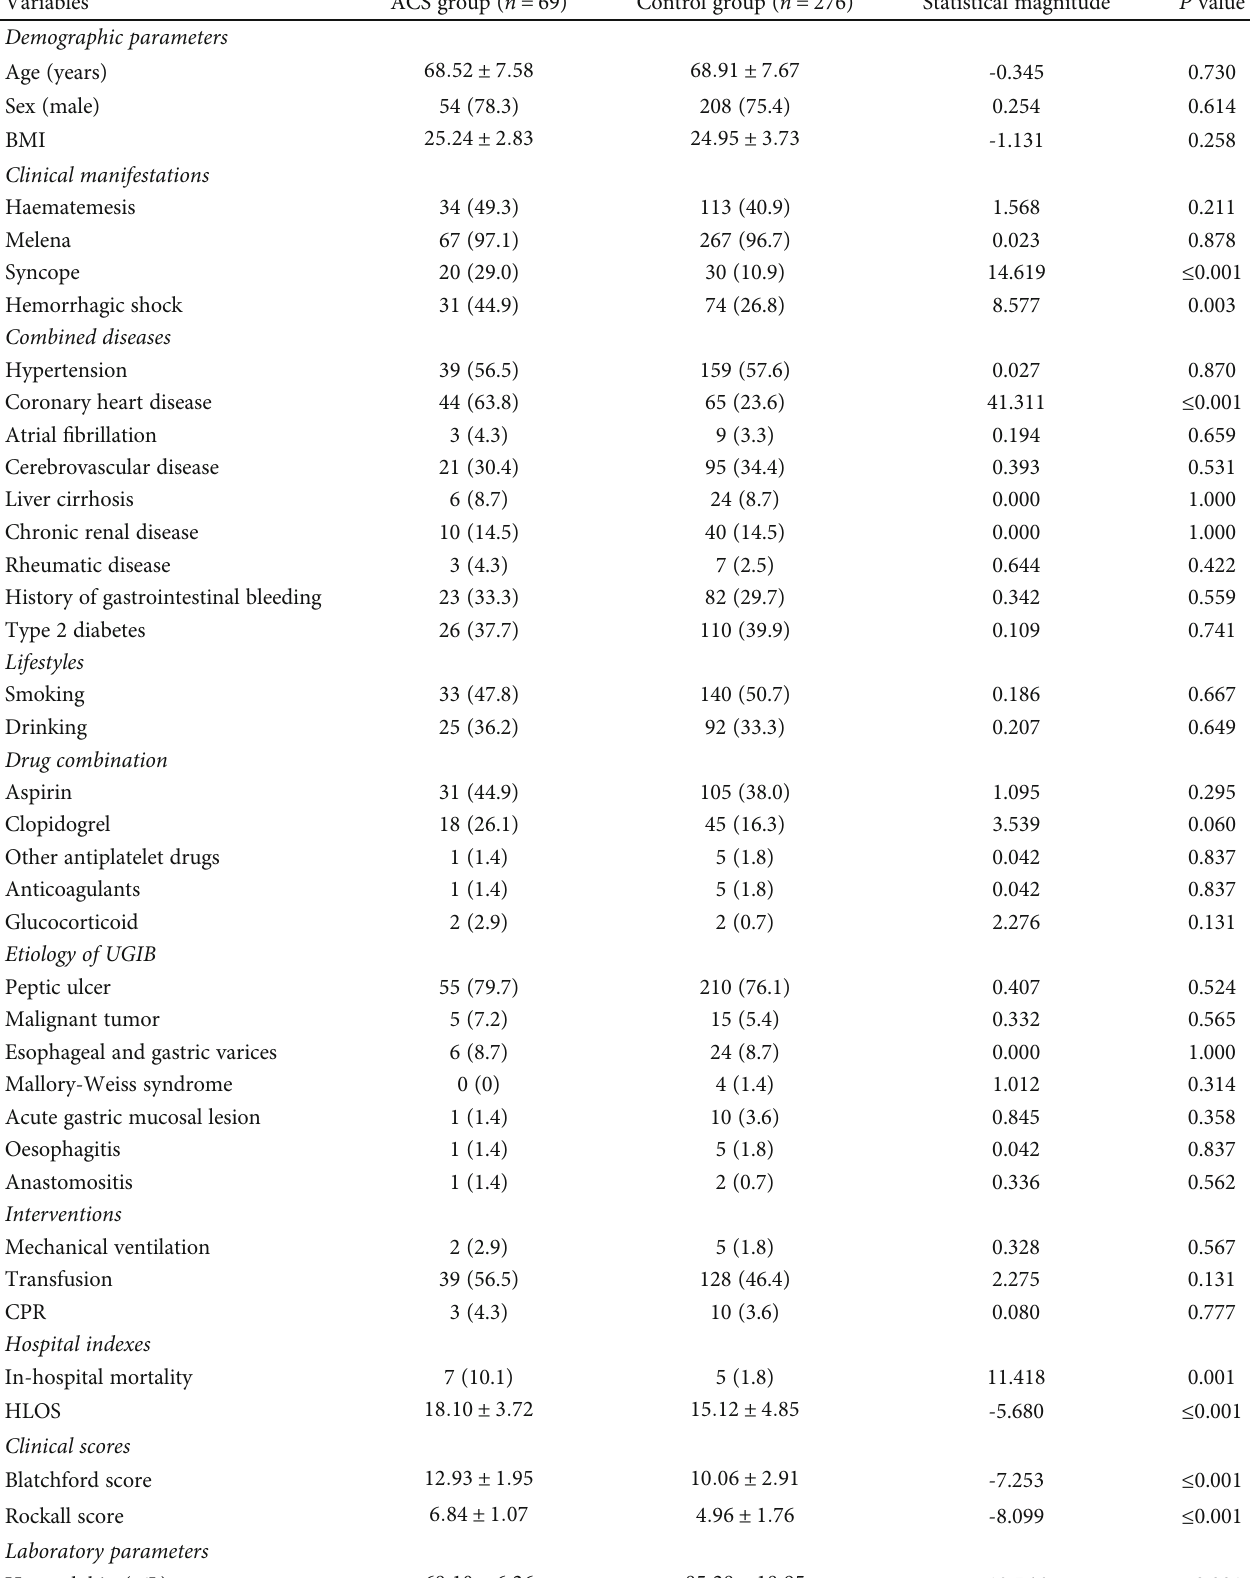
Table 1: Characteristics and single-factor analysis of the ACS group and control group ( n (%), mean ± SD